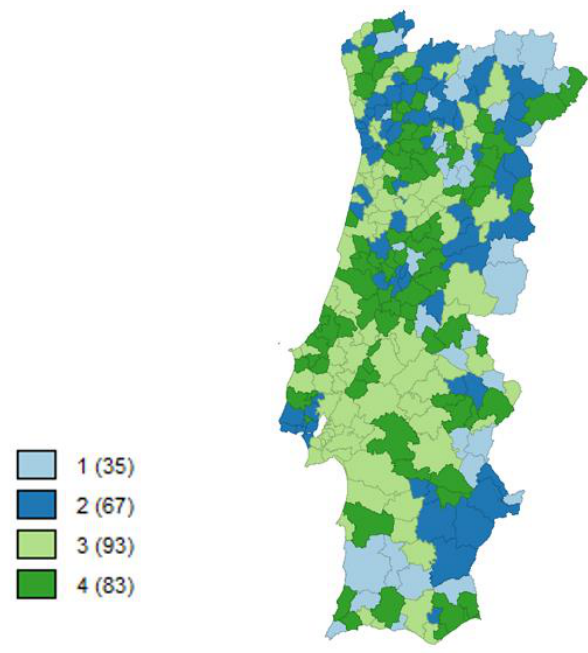
Figure 6. Map with the distribution of the four clusters across the Portuguese municipalities.